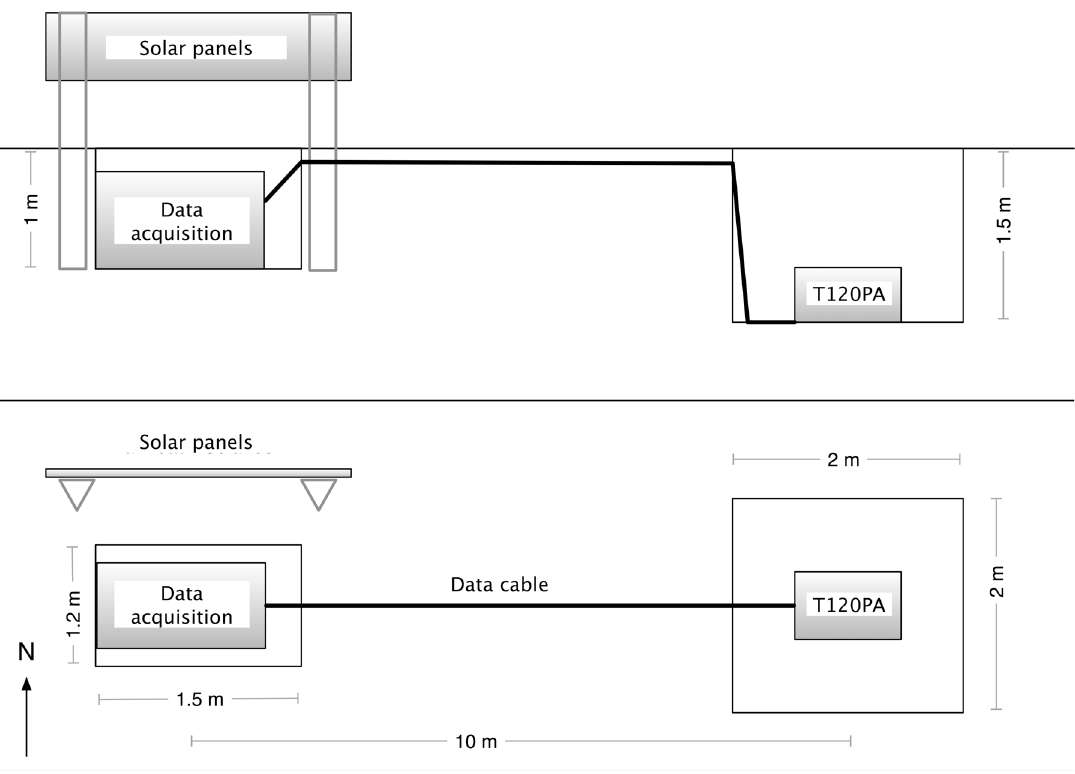
Figure 7. Installation configuration for the CASE-IPY profile stations, indicating the orientation and relative positions of the different com- ponents (top: side view; bottom: view from above).